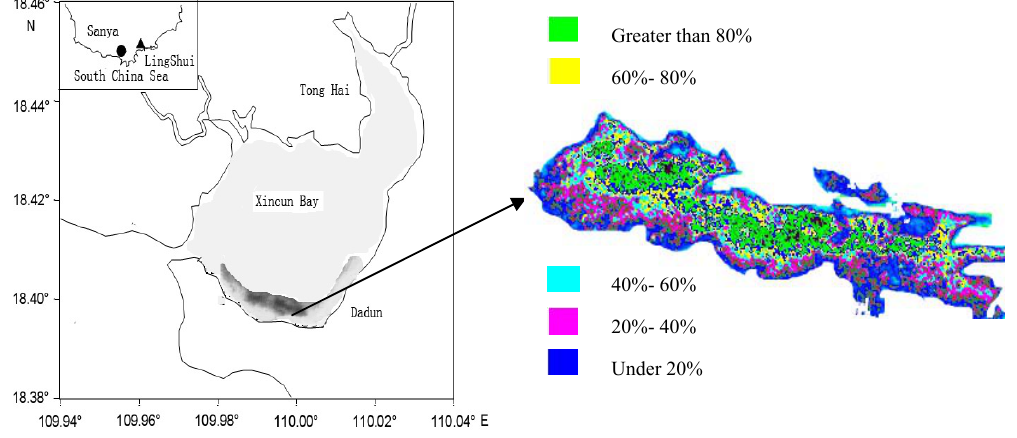
Figure 6. Seagrass density retrieved with